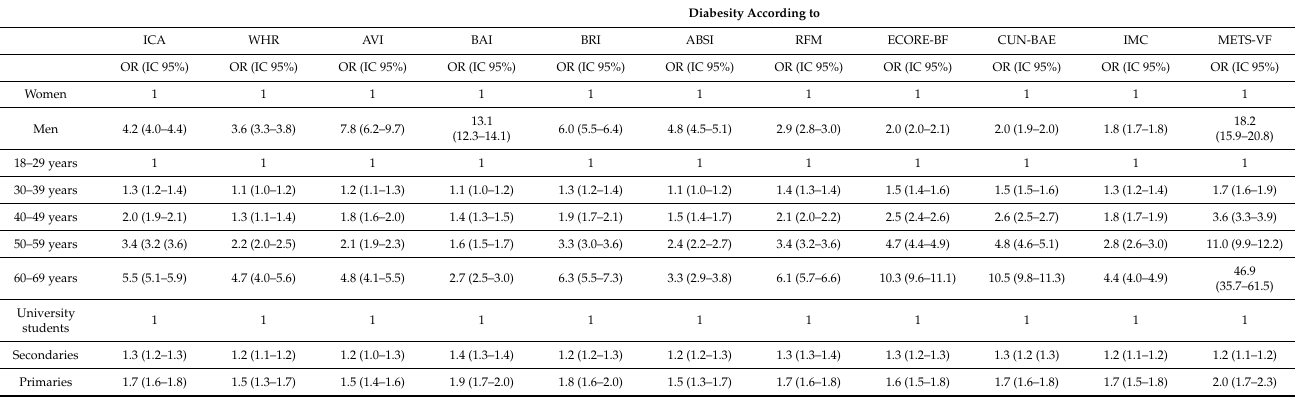
Table 4. Multivariate model with the variables associated with diabesity (multinomial logistic